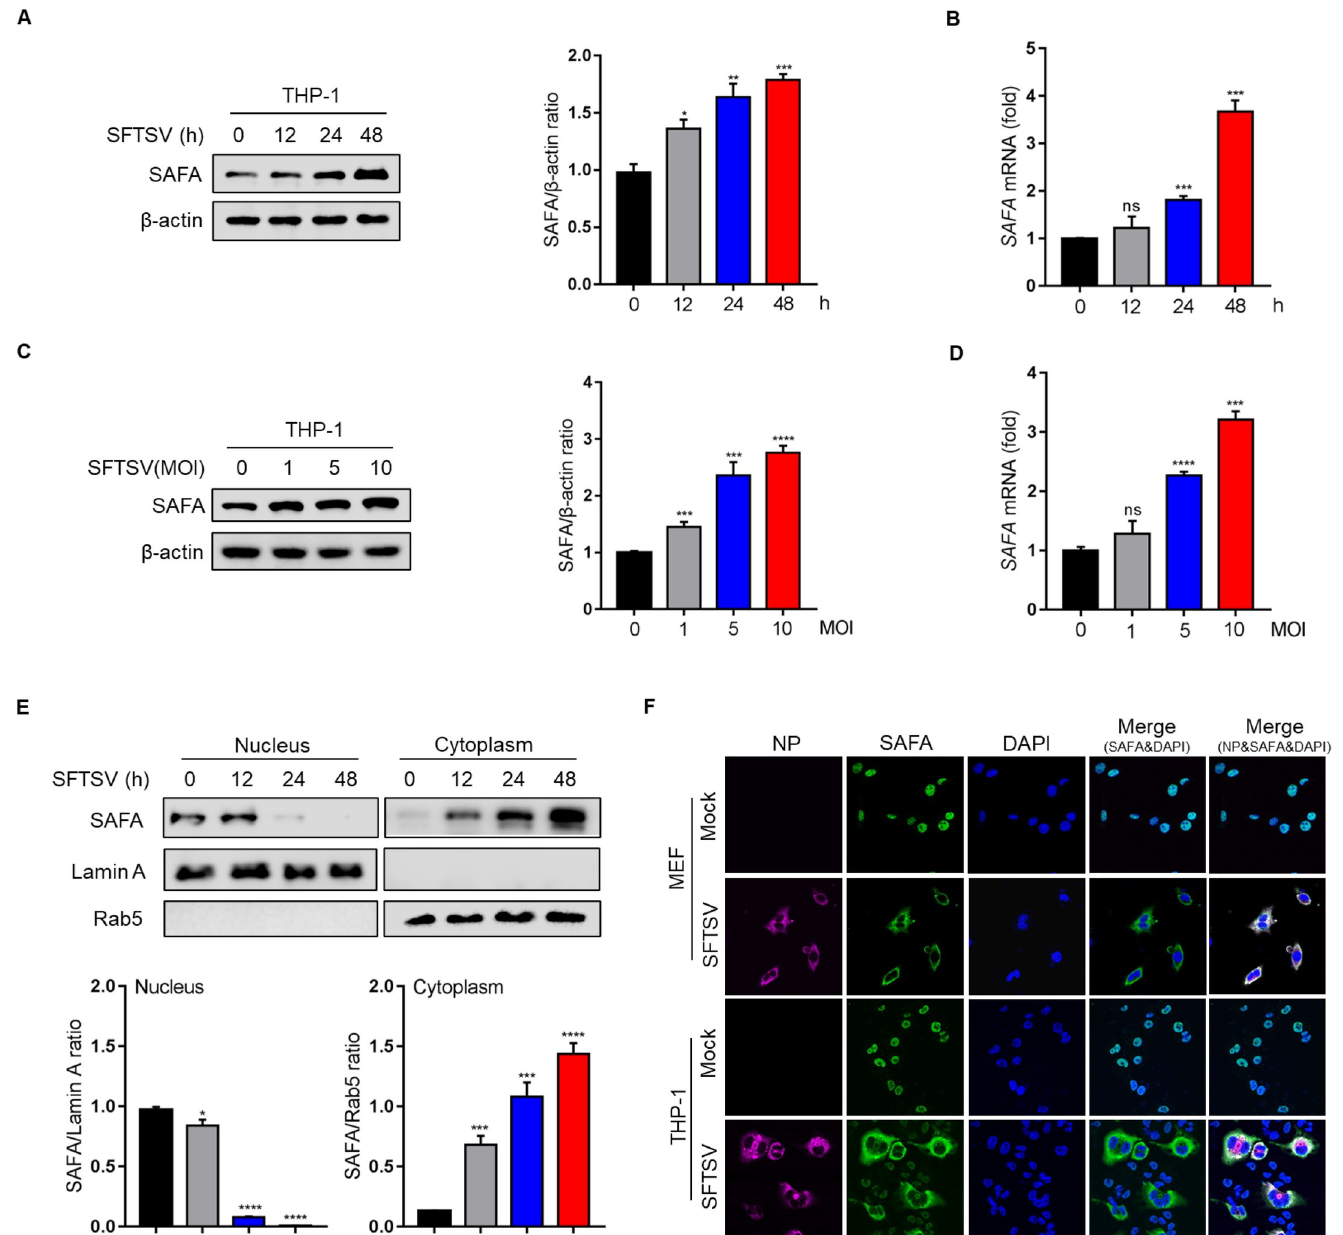
Fig 1. SAFA is involved in the infection of SFTSV. (A) THP-1 cells were infected with SFTSV (MOI = 10) for 12, 24, or 48 h. SAFA protein levels were analyzed by Western blot. Western blot data were semi-quantified and normalized against β -actin protein loading control. (B) THP-1 cells were infected with SFTSV (MOI = 10) for 12, 24, or 48 h. SAFA mRNA was analyzed by RT-PCR. (C) THP-1 cells were infected with SFTSV (MOI = 0, 1, 5, 10) for 48 h. SAFA protein levels were analyzed by Western blot. Western blot data were semi-quantified and normalized against β -actin protein loading control. (D) THP-1 cells were infected with SFTSV (MOI = 0, 1, 5, 10) for 48 h. SAFA mRNA levels were analyzed by RT-PCR. (E) MEF cells were infected with SFTSV (MOI = 10) for the indicated time. Nuclear and cytoplasmic proteins were separated. SAFA, Lamin A, and Rab5 protein levels were analyzed by Western blot. Lamin A and Rab5 were nuclear and cytoplasmic index proteins respectively. Nuclear and cytoplasmic Western blot data were semi-quantified and normalized against Lamin A and Rab5 protein loading control respectively. (F) MEF cells and THP-1 cells were infected with or without SFTSV (MOI = 10) for 48 h, SFTSV NP (purple), SAFA (green), and DAPI (blue) were analyzed by confocal microscopy. Data were obtained from three independent experiments (n = 3). � P < 0.05, �� P < 0.001, ��� P < 0.0001, ���� P < 0.00001, ns, not significant.